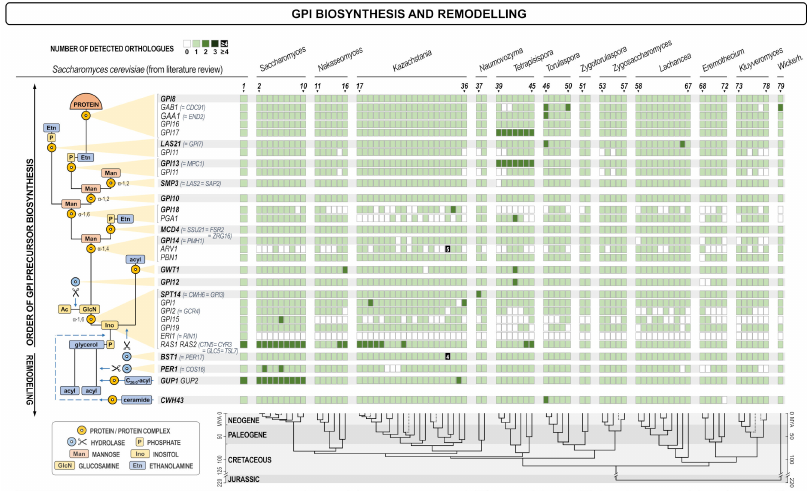
Figure 3. Heat map of orthologues of S. cerevisiae genes involved in the synthesis of GPI and the GPI-protein conjugates. Every gene is presented in one row, while every yeast (see the legend of Figure 1) is presented in one line. The scheme of the cellular process with the site in which the product of each gene is involved is shown on the left. The intensity of the color of every square is proportional to the number of orthologues found as depicted in the inset legend. White square means no orthologue has been found. The lower part of the figure presents the evolutionary chronogram of each species. Genes coding for catalytic subunits are presented in bold and have a grey background if they are parts of a bigger